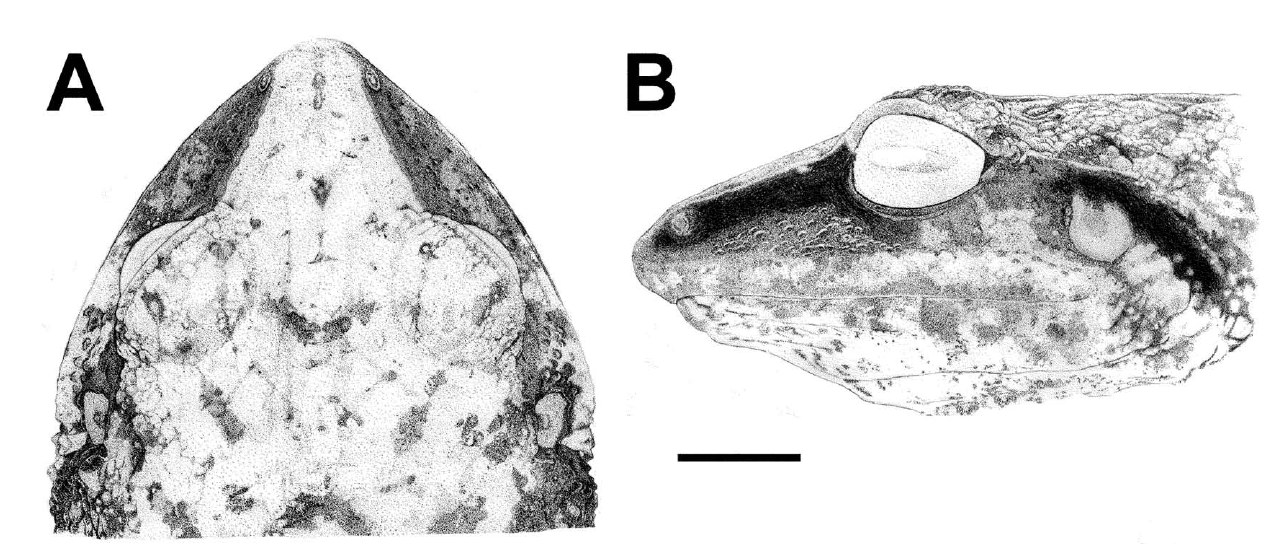
Figure 3. Strabomantis aramunha